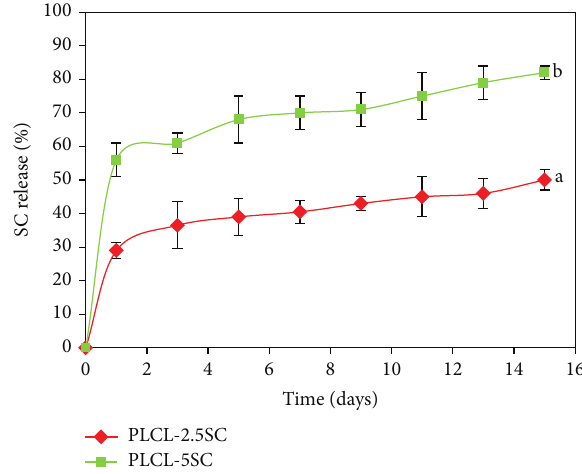
Figure 7: Release profile of SC from PLCL-SC membranes. Statisti- cal differences between each group are represented as the lowercase letters (a, b) ( 𝑝 ≤ 0.05